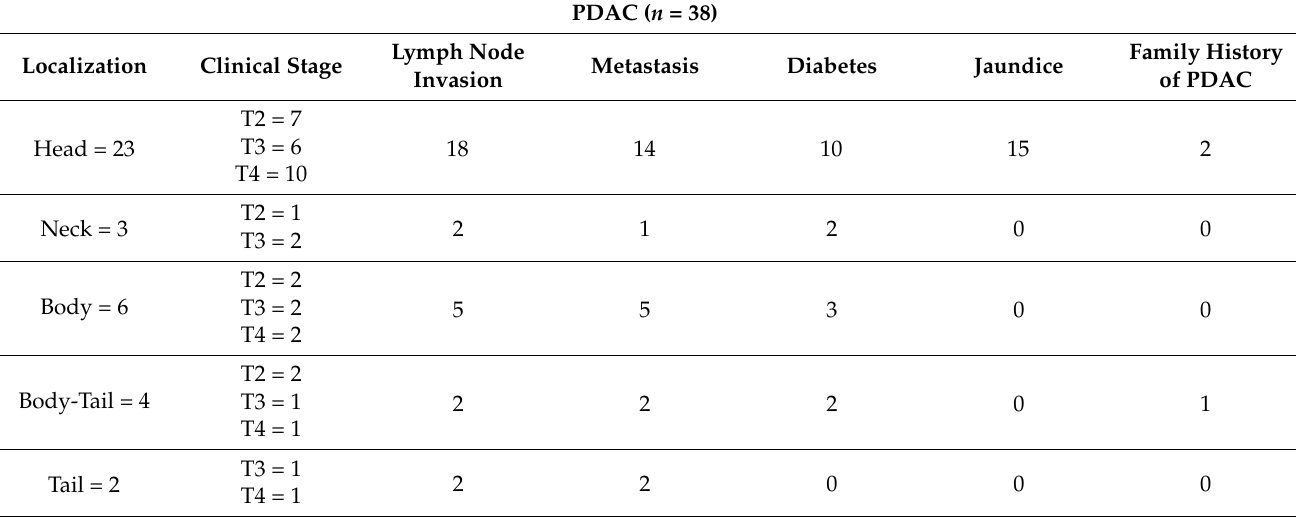
Table 2. Clinical features of PDAC